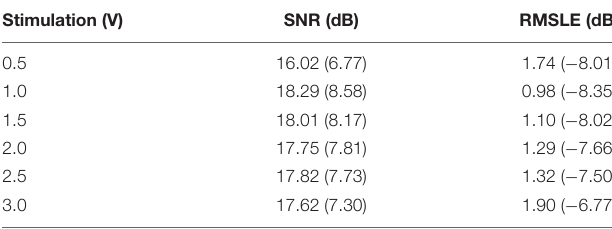
TABLE 2 | Performance evaluation of electrocardiogram (ECG) artifact removal without extra filtering deep brain stimulation (DBS) artifacts. Stimulation